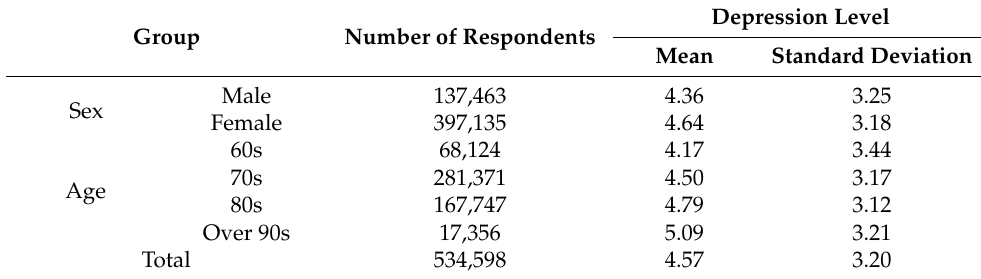
Table 1. Basic statistics of the individual